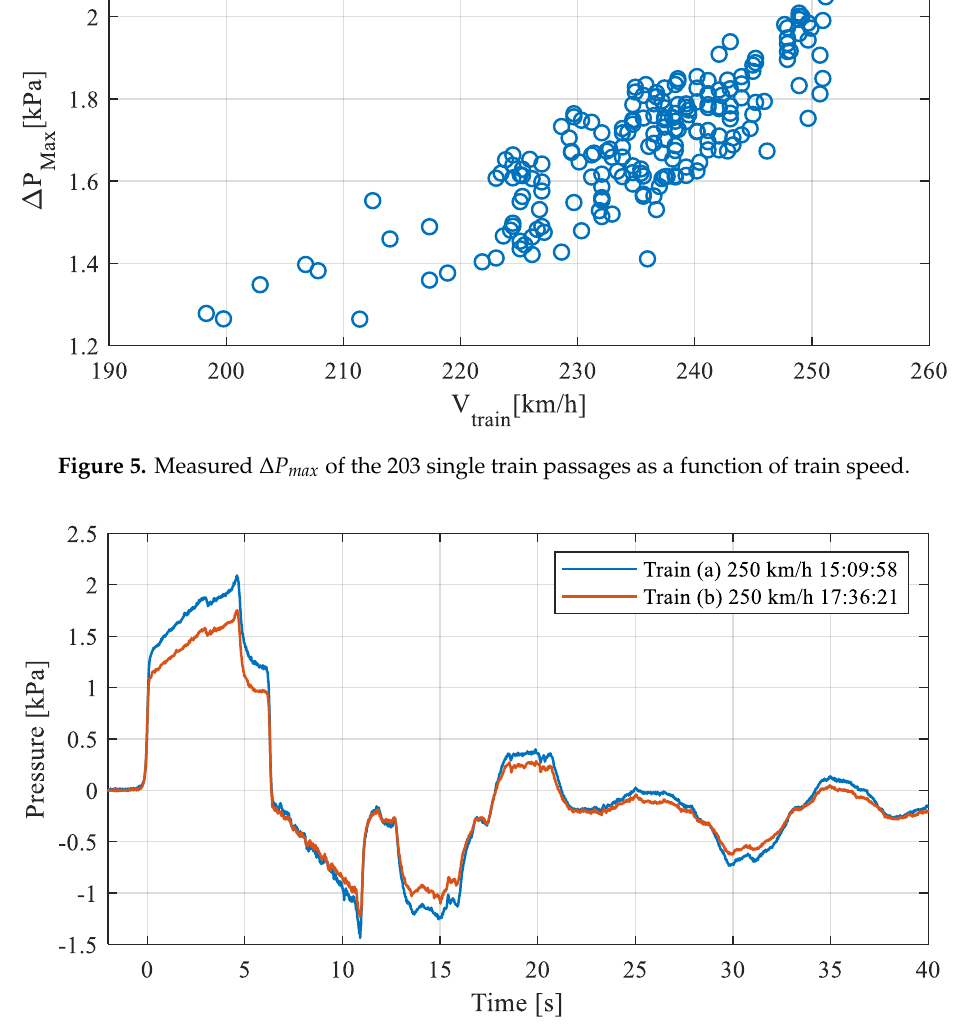
Figure 6. Comparison between two time histories of the pressure generated by two trains; same train type, same tunnel, same speeds, same day. Table 1. Timetable of the four passages considered in the